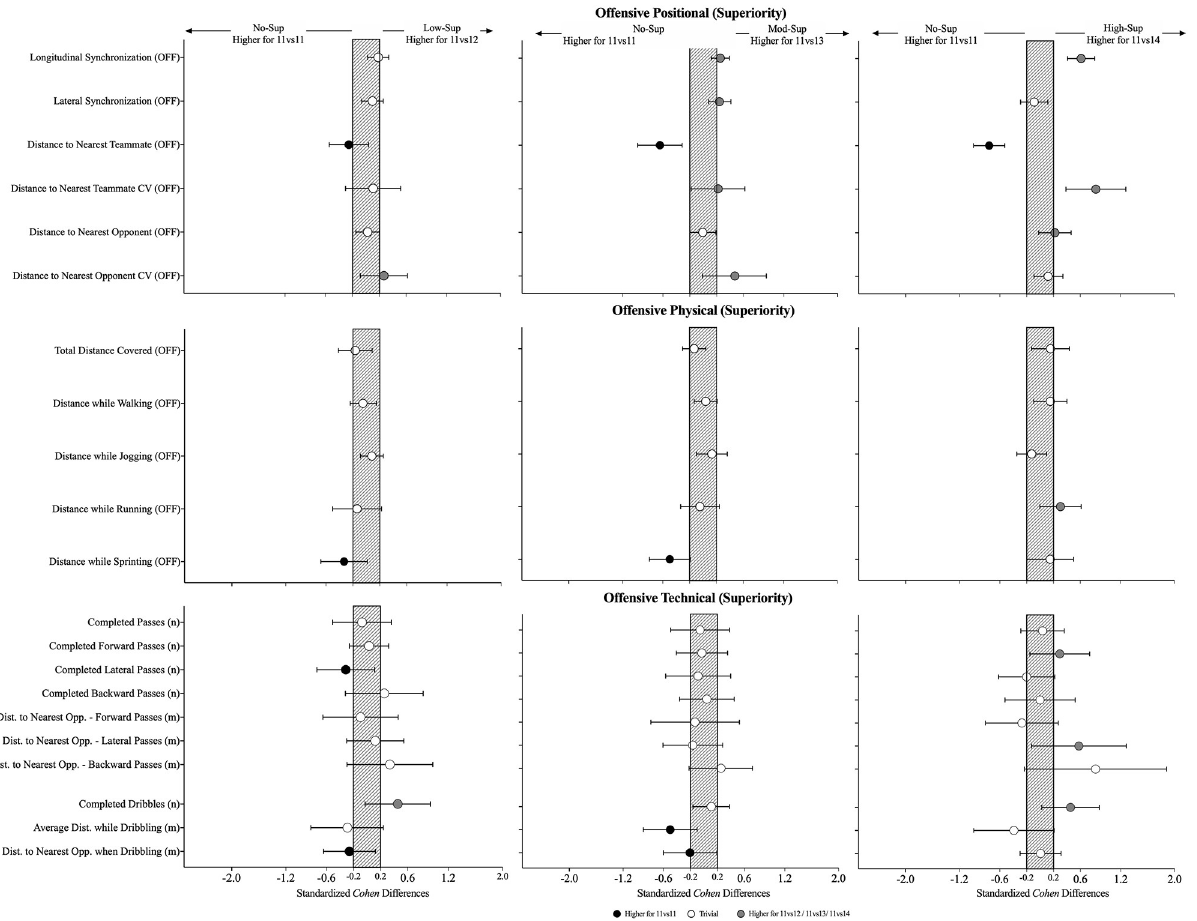
Fig 2. Standardised (Cohen) differences in physical, individual and collective tactical variables considering the increase in the number of teammates (cooperation-perspective) during the offensive phase. Error bars indicate uncertainty in the true mean changes with 90% confidence intervals. OFF =